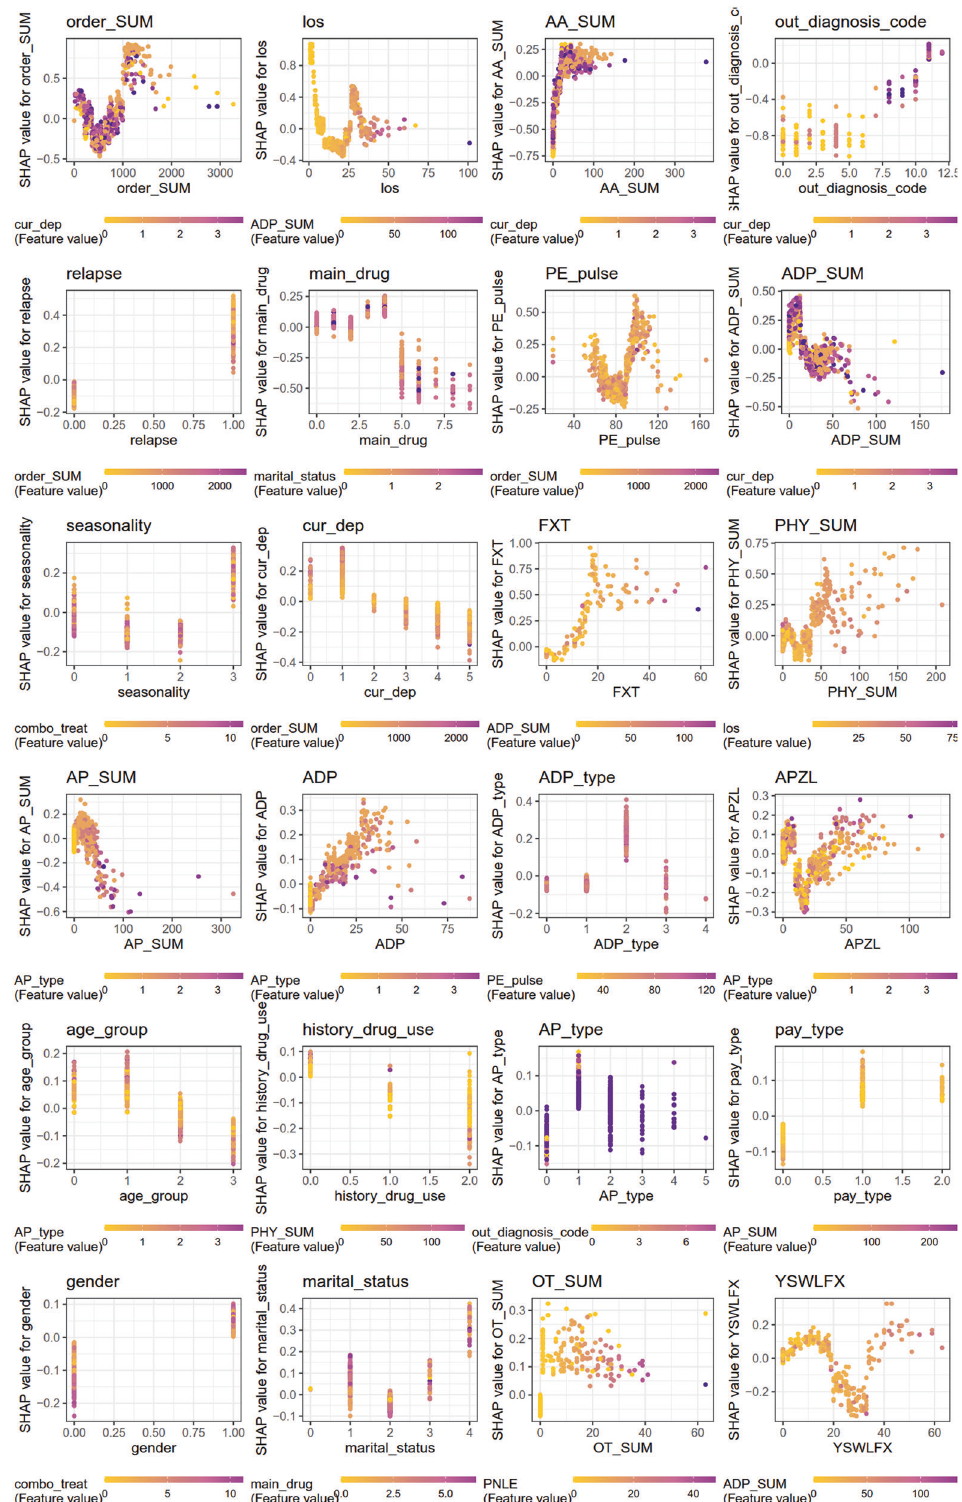
Fig. 8 Feature interactions of 24 top important features of the 30-day